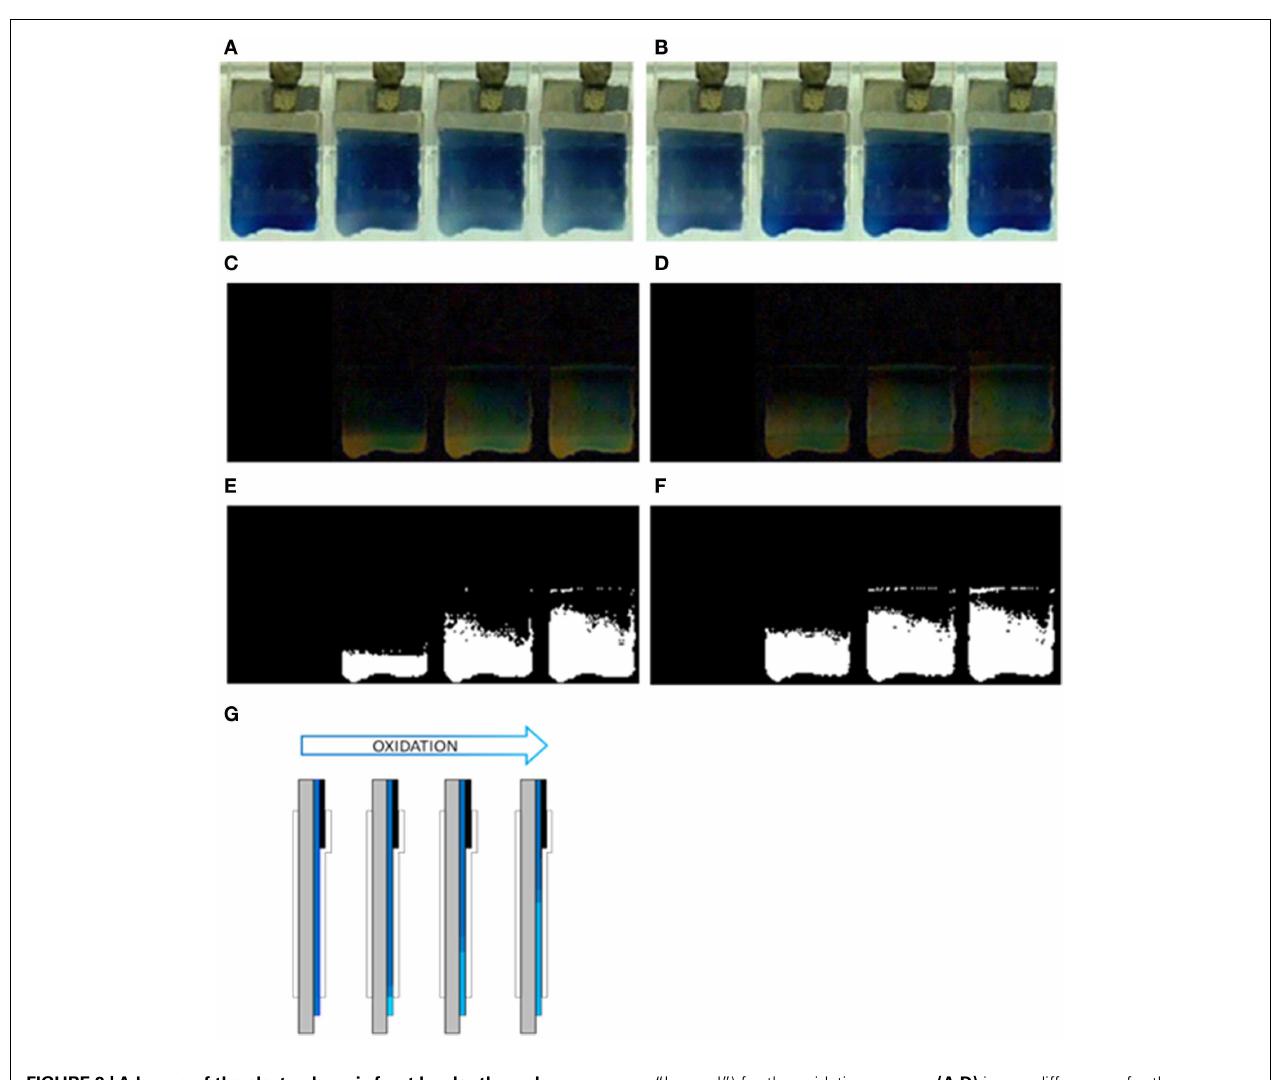
FIGURE 3 |Advance of the electrochromic front border through PEDOT–PSS films casted on glass in 0.2M LiClO 4 aqueous solution . (A) Oxidation process at 0.20V after 0, 2, 6, and 9s. (B) Reduction process at − 1.00V after 0, 2, 6, and 10s. (C) Image differences with that at time 0s (using the image treatment program